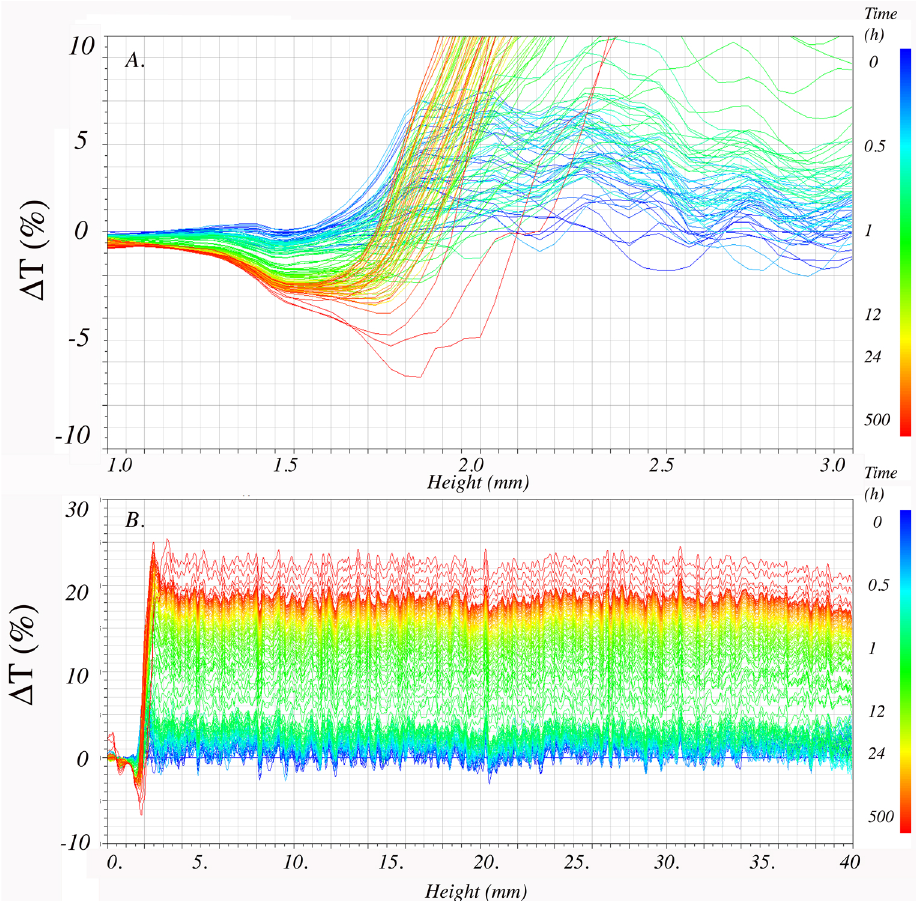
Figure 9. Delta transmittance profile of Bi-MD-Pectin microcapsules dispersed in water obtained over 40 days of storage in sample flasks. Sedimentation is shown in the bottom of the flasks (heights between 1 mm and 3 mm) and flocculation in the middle section of the flasks (heights between 3 mm and 37 mm). A blue line shows proximity to day 0. A red line shows proximity to day 40. ( a ) is an expansion of ( b ) between 1 mm and 3